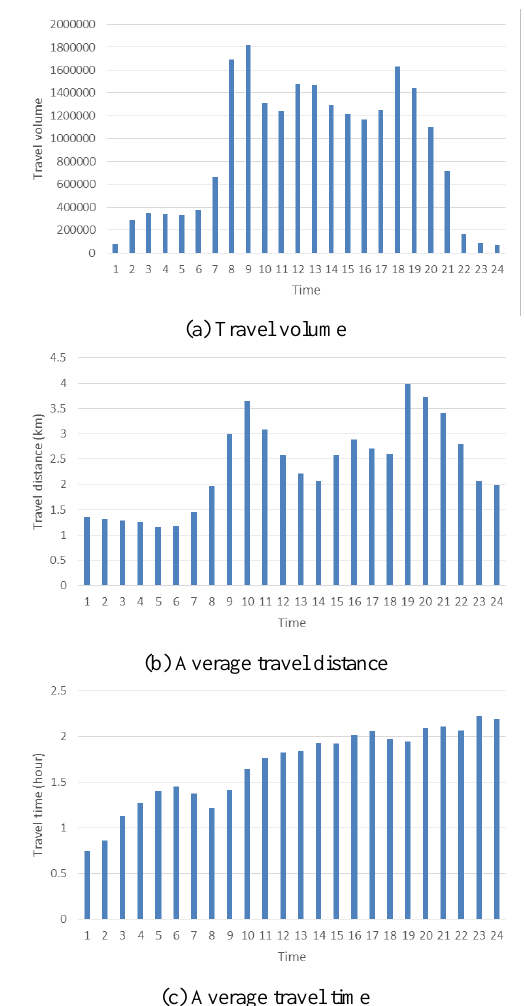
Figure 5. Temporal variation of trips inferred from mobile phone